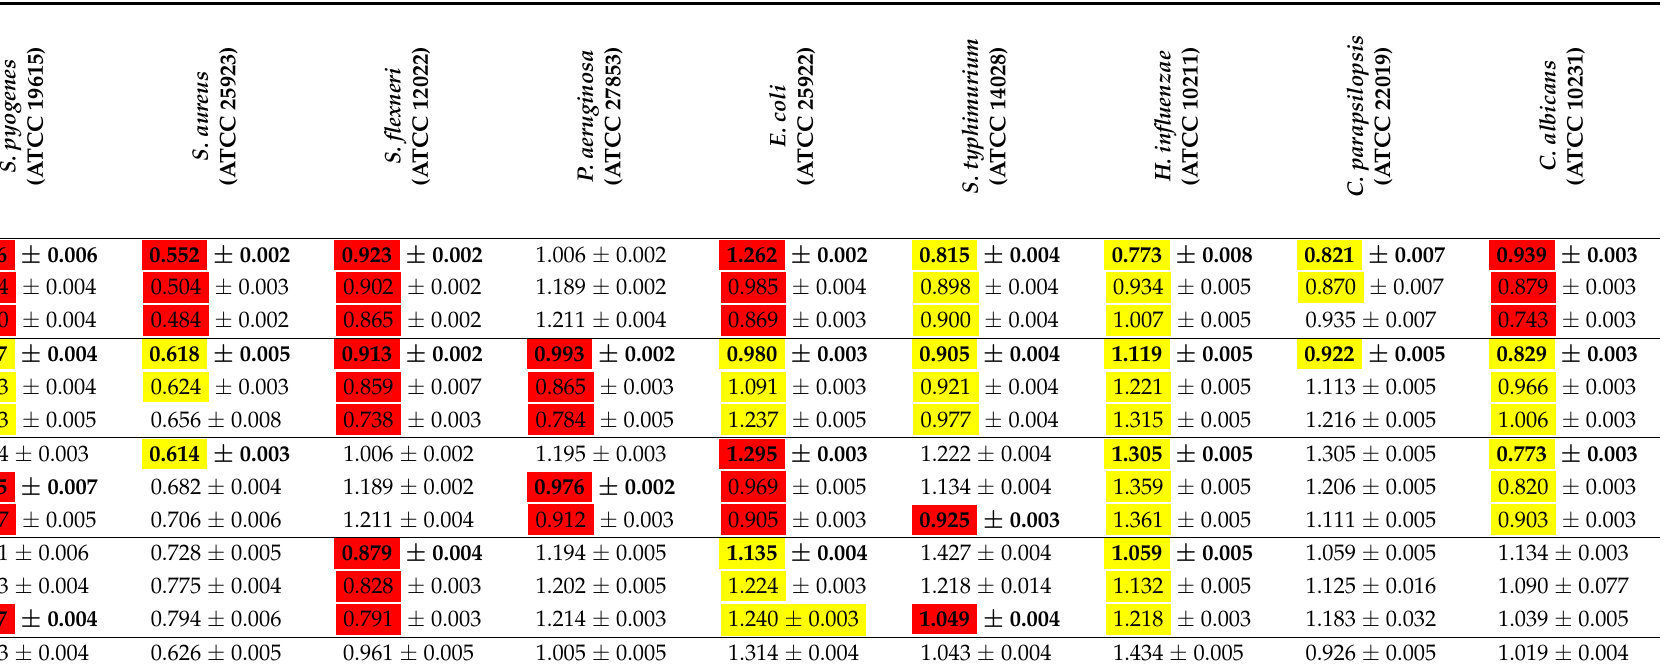
Table 1. The OD reading of honey samples tested on the ATTC